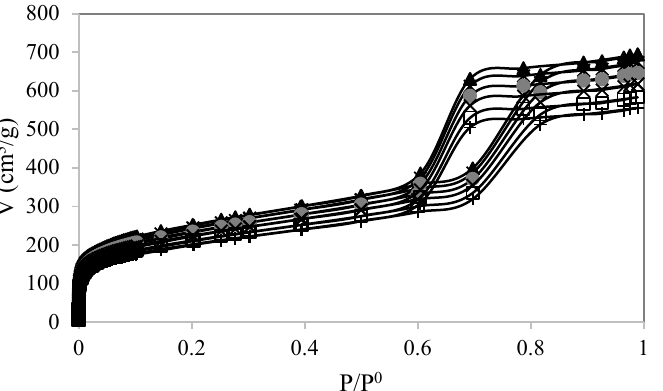
Figure 1. N 2 isotherms of materials. ( (cid:78) ) KIT-6; ( ∗ ) PW1-K-6; ( ) PW2-K-6; ( × ) PW3-K-6; ( ) PW4-K- 6; (+) PW5-K-6. Table 1. Characterization of KIT-6 and KIT-6 (K-6) with heteropolyacid.